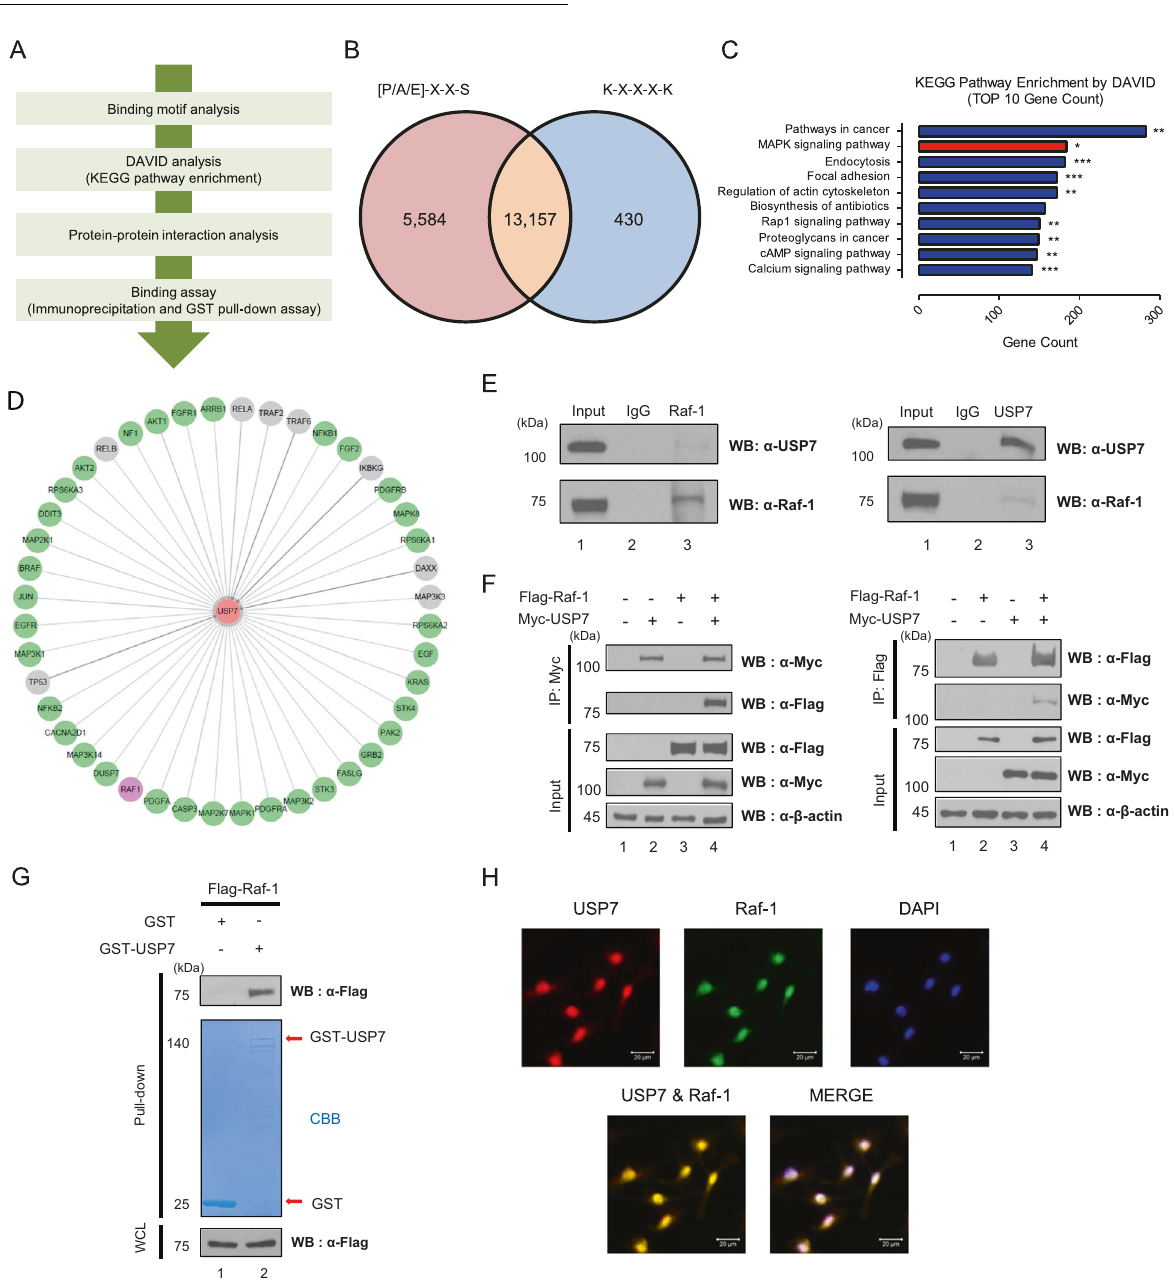
Cell Death and Disease (2022)